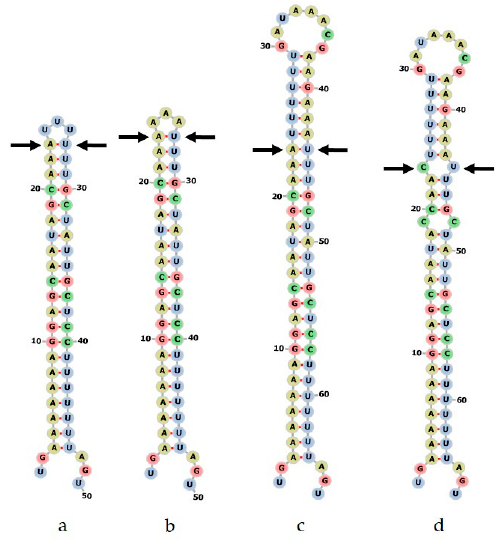
Figure 4. Predicted RNA secondary structures of Hypericum psbA 3 ′ UTR sequences. a, H. perforatum